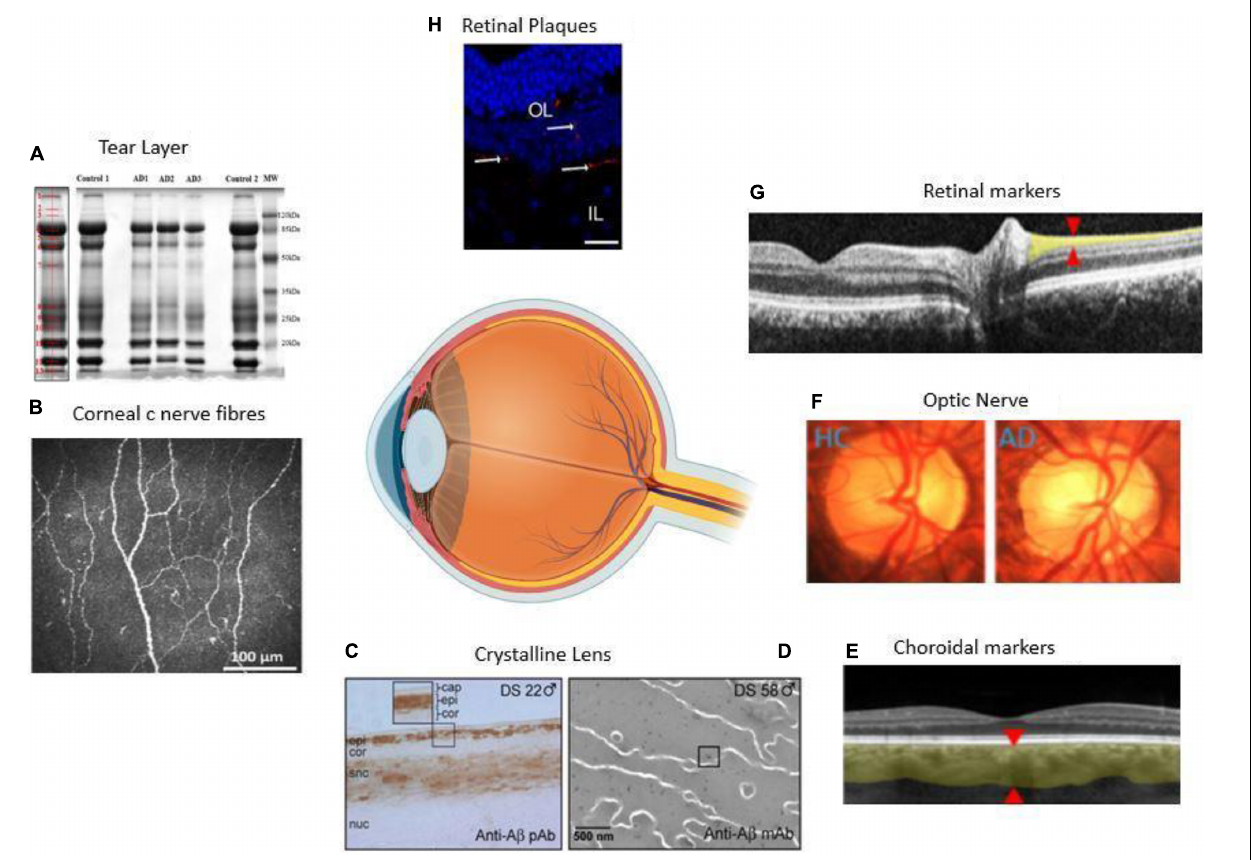
FIGURE 1 | Anatomical locations of ocular biomarkers reviewed in this paper (anti-clockwise from anterior segment to posterior segment). (A) Changes in the tear proteome in Alzheimer’s disease (AD). Tear proteins from three AD and two controls are shown by gel imaging. The representative band distribution is demonstrated on the left and was detected with QuantityOne (Kalló et al., 2016). (B) Imaging of the cornea using corneal confocal microscopy in a healthy control (HC) demonstrating normal corneal nerve morphology (Tavakoli et al., 2015). (C) A lens from a male with Down’s syndrome (DC) showing amyloid- β (A β ) immunoreactivity in the epithelium, deep cortex, and supranuclear regions. The box shows the magnified detail of the anterior lens (Goldstein et al., 2003). (D) Anti-A β immunogold electron microscopic analysis of lens from a male with DC. Heterogeneous distribution of anti-A β immunoreactive protein aggregates of 5–200 nm localizes heterogeneously within the lens fiber cell cytoplasm (Moncaster et al., 2010). (E) Thinning of the choroid demonstrated using optical coherence tomography (OCT) in an AD patient. The red arrowheads denote where the measurements are taken (Lim et al., 2016). (F) Optic nerve pallor imaged using a laser Doppler imaging device. The left panel shows the optic nerve of HC, and the right shows the optic nerve of an AD patient (Lim et al., 2016). (G) Thinning of the RNFL imaged using OCT. The red arrowheads show where the measurements are normally taken (Lim et al., 2016). (H) Immunolabeled retinal slice with anti-A β antibodies (red), and Hoechst (blue) to visualize nuclei in late-stage AD in a transgenic mouse (Grimaldi et al., 2018). HC = healthy control, AD = Alzheimer’s disease, Cap = capsule, epi = epithelium, cor = cortex, snc = supranuclear, nuc = nucleus, DS = Down’s syndrome, OL = outer layer, IL = inner